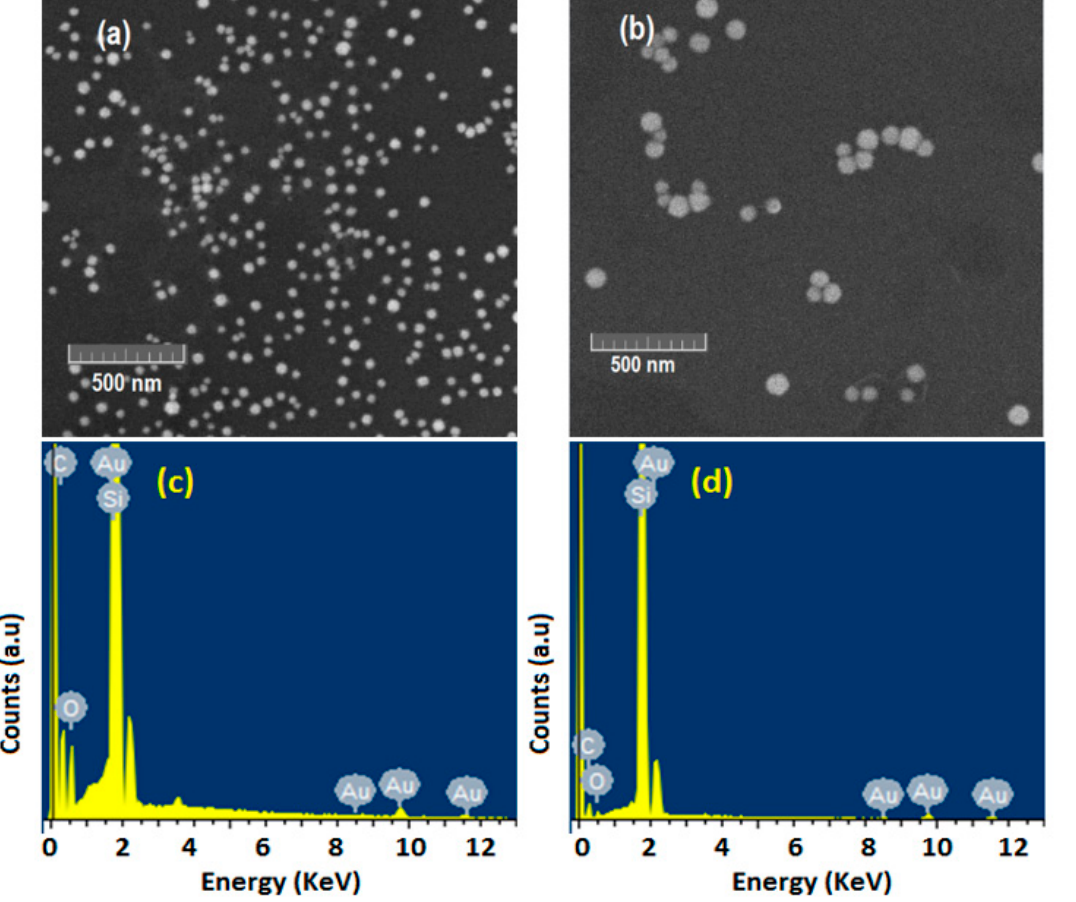
Figure 3. SEM images of ( a ) DF-AuNPs, ( b ) SF-AuNPs and EDX, ( c ) DF-AuNPs, ( d ) SF-AuNPs. The composition of elements in the as-synthesized DF − AuNPs and SF − AuNPs determined using EDX are given in Figures 3c and 3d, respectively. As per elemental identification carried out via EDX spectrum, the sample comprises Au (due to AuNPs ), carbon (likely due to DF , or due to burning during scanning), silicon (due to SiO 2 substrate on which DF − AuNPs and SF − AuNPs were deposited), and oxygen (due to DF ). Figure 4a depicts the XRD patterns of SF − AuNPs and DF − AuNPs . In the figure, the Bragg’s peaks at 38.2 ◦ , 44.5 ◦ , 64.9 ◦ , and 77.9 ◦ correspond to the (111), (200), (220), and (311) planes of the face-centered cubic ( FCC ) crystalline structure of pure gold. The peaks match well with the reference card for gold JCPDS File number 04 − 0784 (black plot in Figure 4a). These XRD patterns confirm the crystalline nature of SF − AuNPs and DF − AuNPs . These XRD spectra also point to the formation of pure gold nanoparticles in the